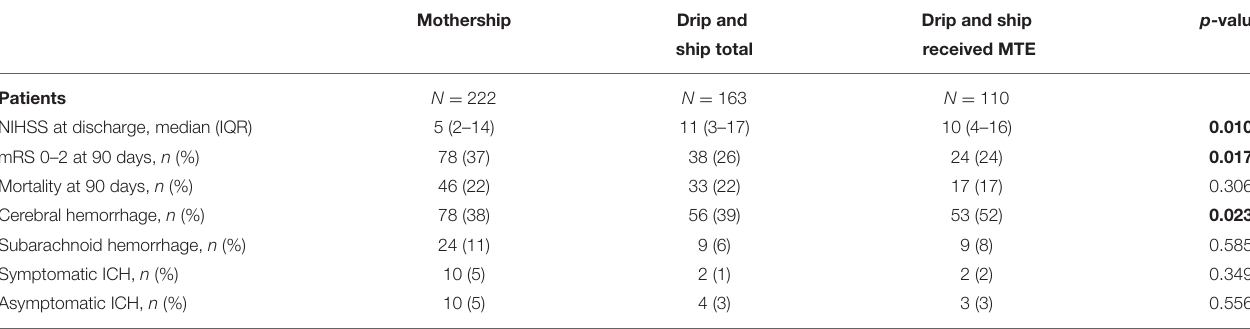
TABLE 2 | Clinical outcomes.